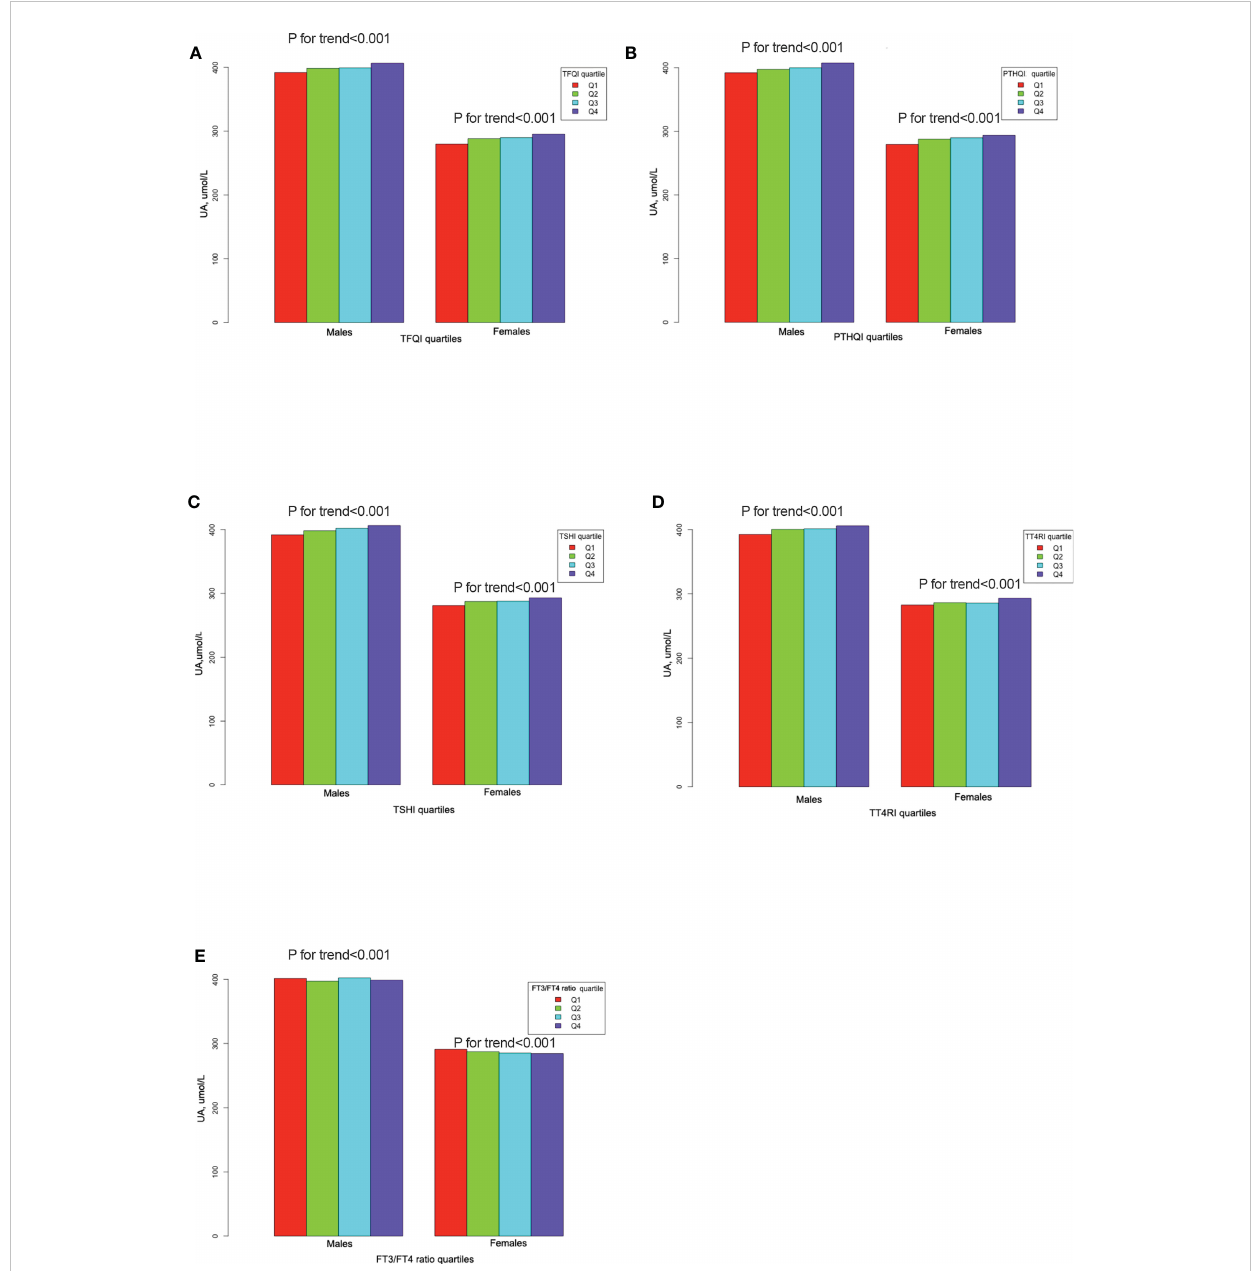
FIGURE 2 The UA levels across thyroid parameter quartiles. (A) The UA levels across TFQI quartiles. (B) The UA levels across PTFQI quartiles. (C) The UA levels across TSHI quartiles. (D) The UA levels across TT4RI quartiles. (E) The UA levels across FT3/FT4 ratio